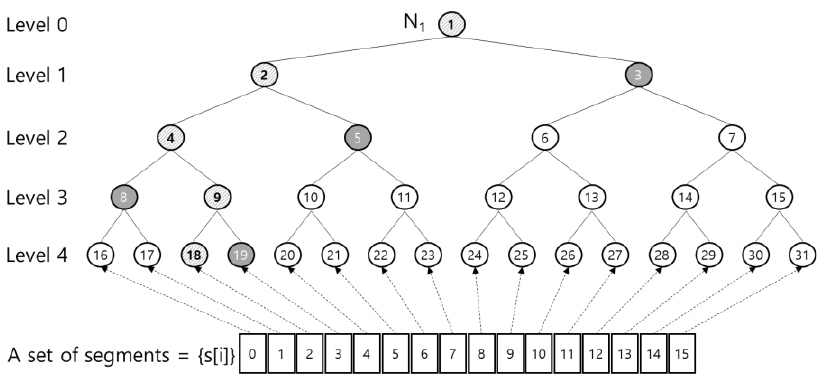
Figure 1. The structure of the MHT to verify 16 segments of data.